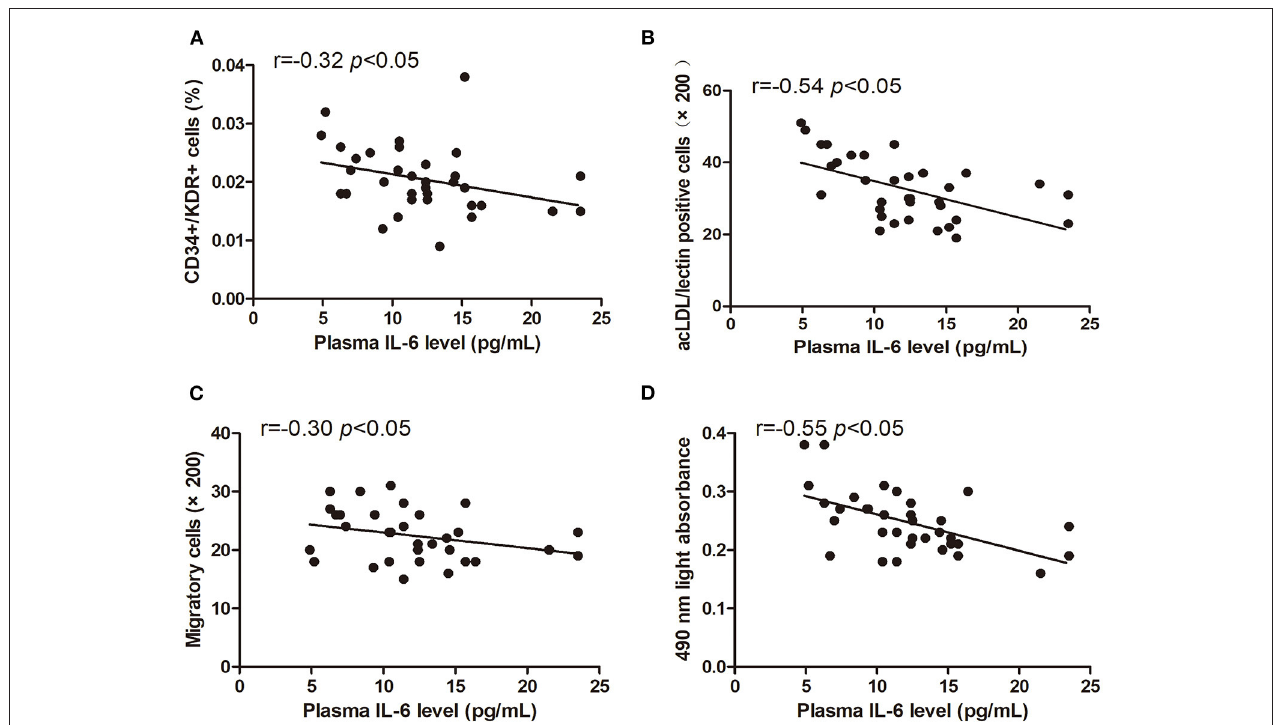
FIGURE 5 | Pearson correlation ratios were used to analyze the relationship between the number or function of EPCs and plasma IL-6 level. The CD34 + KDR + positive cells (A) and DiI-acLDL/lectin positive cells (B) significantly correlated with IL-6. The migratory (C) and proliferative (D) activities of EPCs were related to